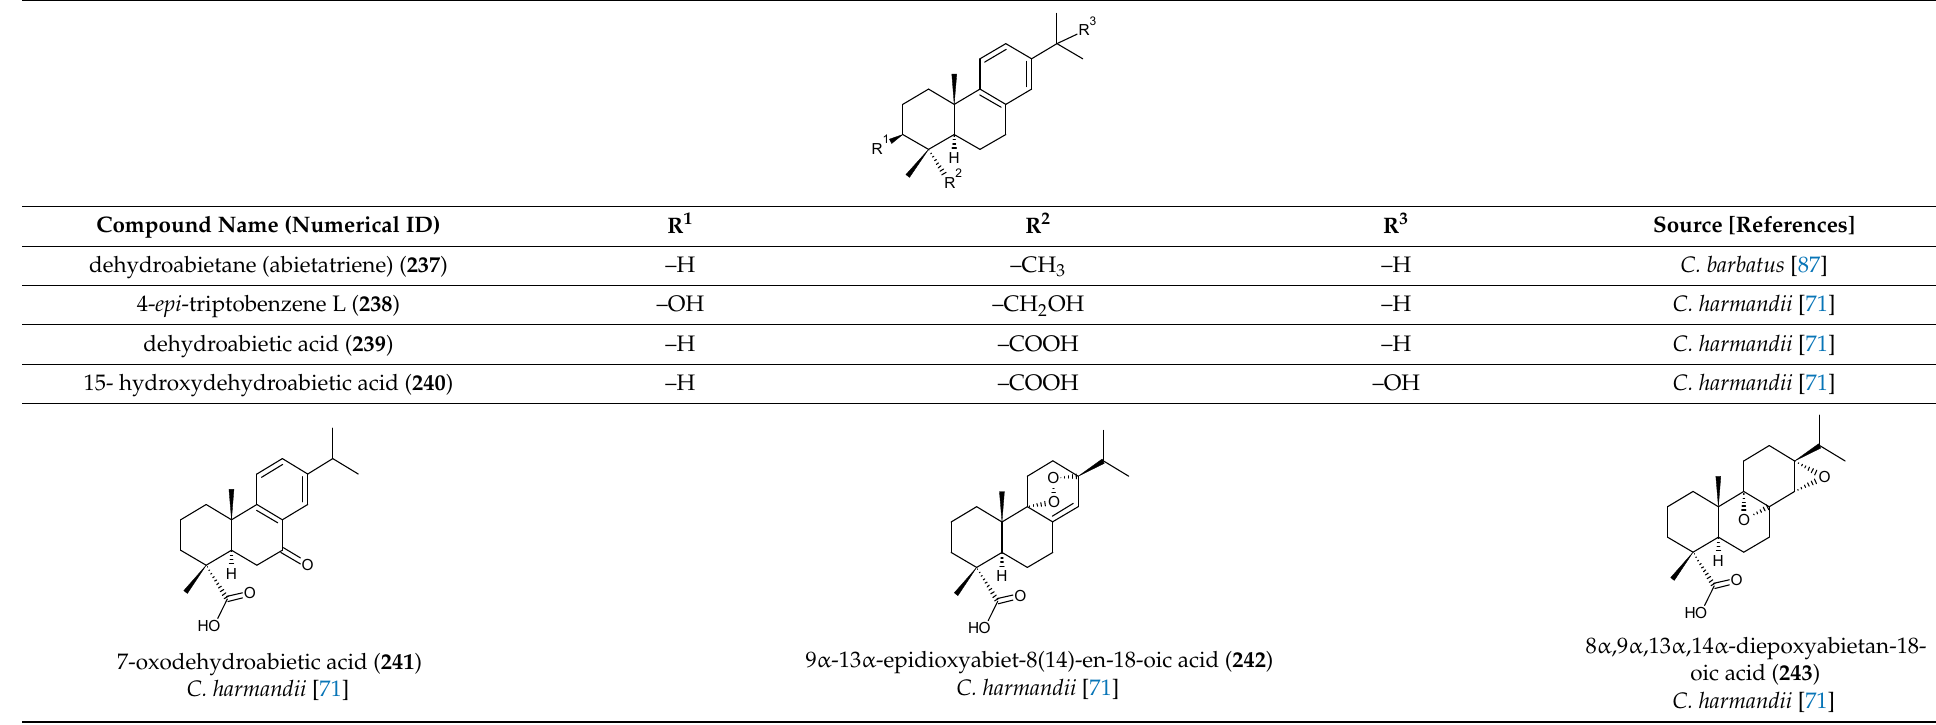
Table 9. Non-phenolic abietanes of the genus Plectranthus s.l.